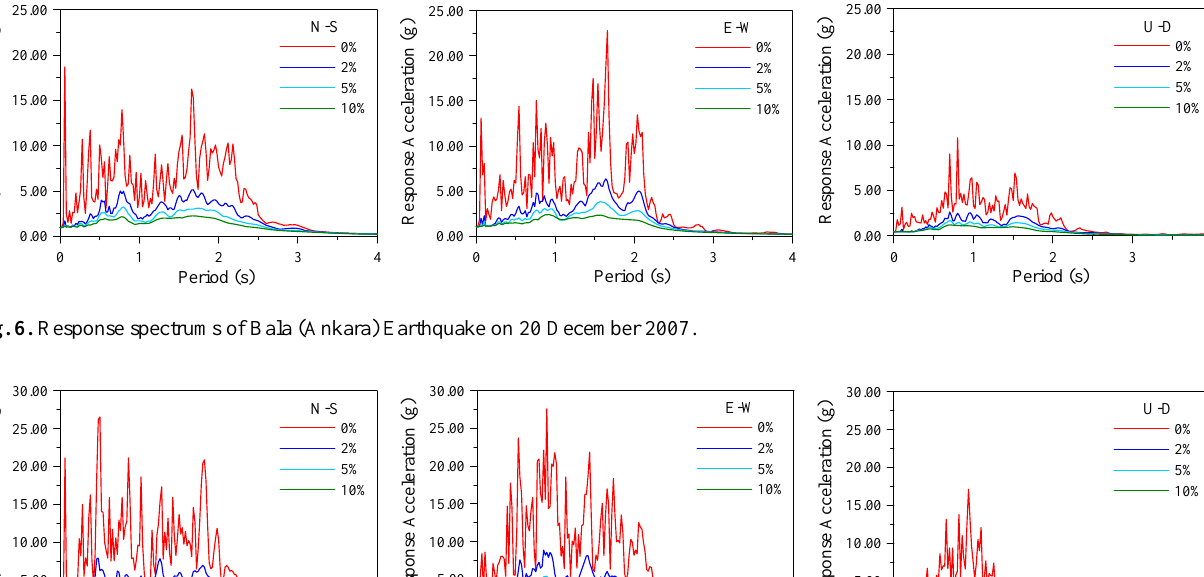
Fig. 6 Response spectrums of Bala (Ankara) Earthquake on December 20, 2007. Fig. 7. Response spectrums of Bala (Ankara) Earthquake on 27 December 2007. Fig. 7 Response spectrums of Bala (Ankara) Earthquake on December 27, 2007.